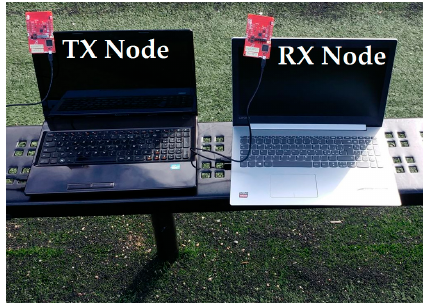
Figure 7. WMCU communication range measurement setup.